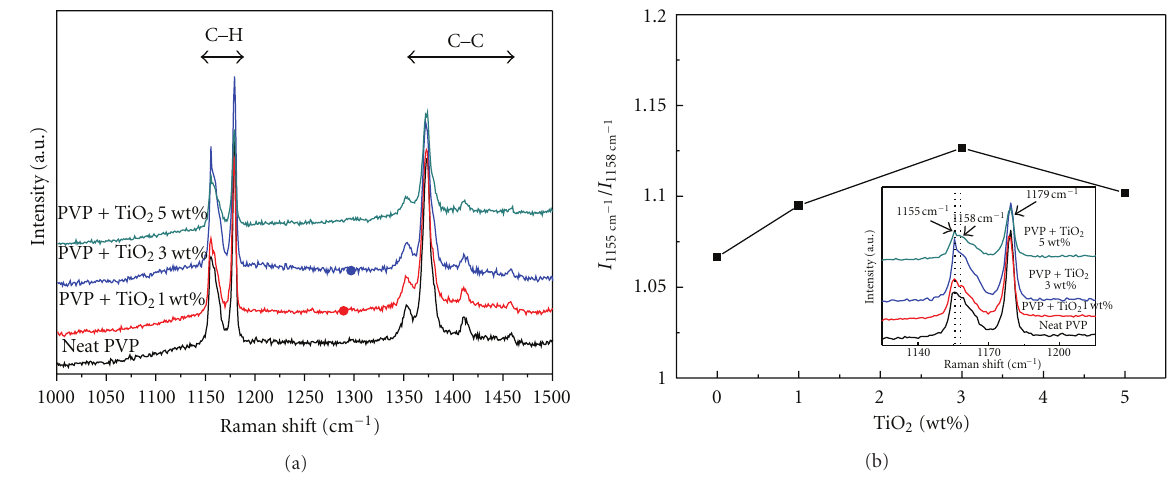
Figure 8: (a) Raman spectrum for pentacene films on printed NC-films; (b) Intensity ratio of 1155 and 1158 cm − 1 with various doped content. Table 2: Electrical characteristics of thermally pentacene TFTs prepared with various doping concentration whose nanocomposite insulators were fabricated by IJP and